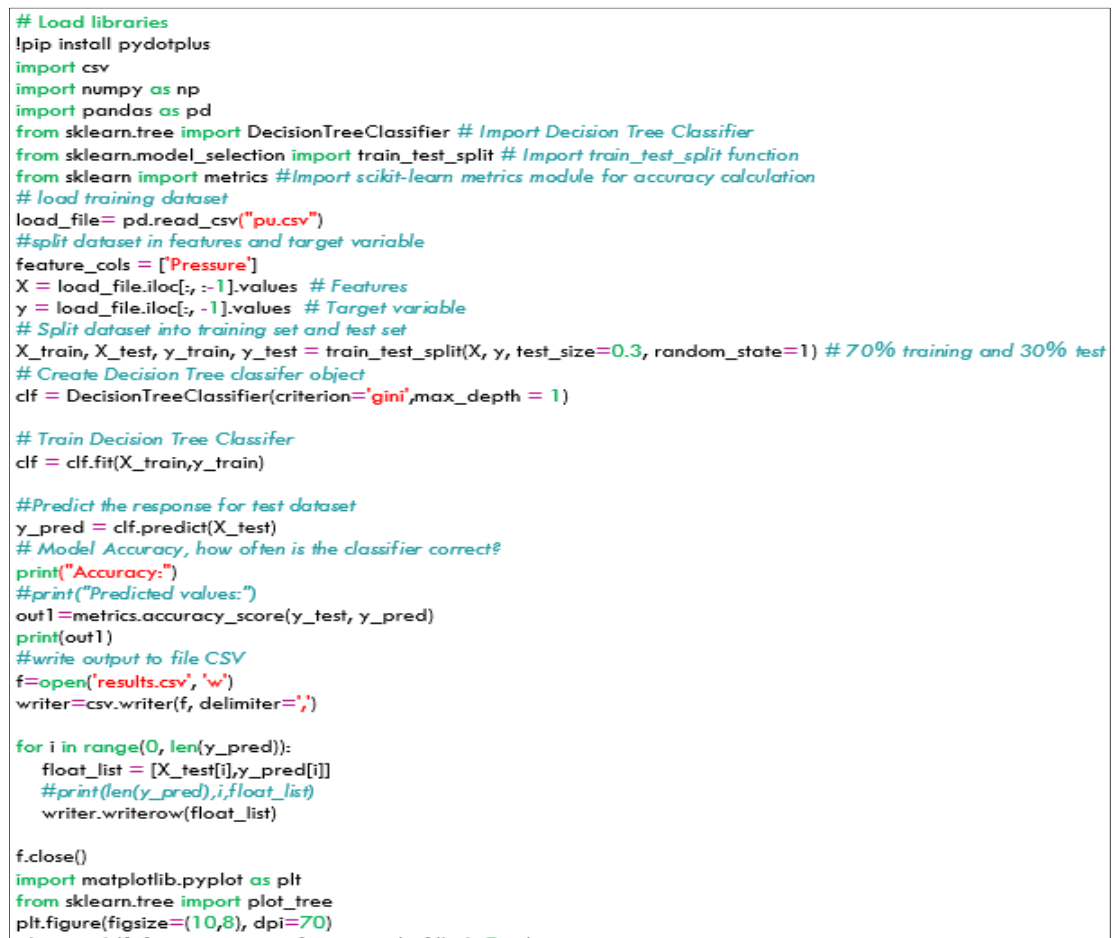
Figure 10. Chiller DT.